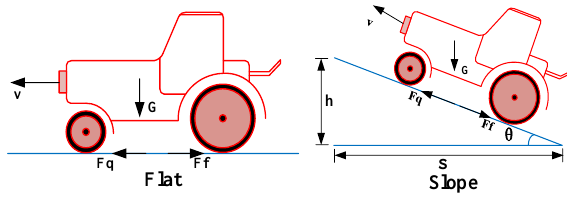
Figure 6. Force analysis of electric tractor.